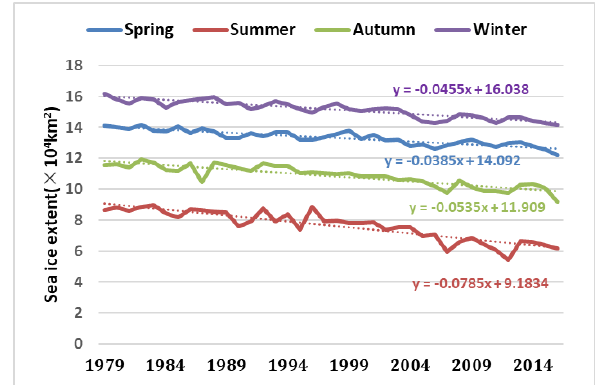
Figure 1. Annual anomaly of sea ice extent in Arctic from 1979 to 2016 There are various technical definitions of seasons in Arctic. According to (Xia et al., 2014), it is defined that spring is from April to June, summer is from July to September, autumn is from October to December, and winter is from January to March. In figure 2, the seasonal change trends of sea ice extent in Arctic are presented. It is shown that sea ice is melting in all seasons, and the melting rate is 7.85 × 10 4 km 2 /y in summer, which is the fastest season in a year.